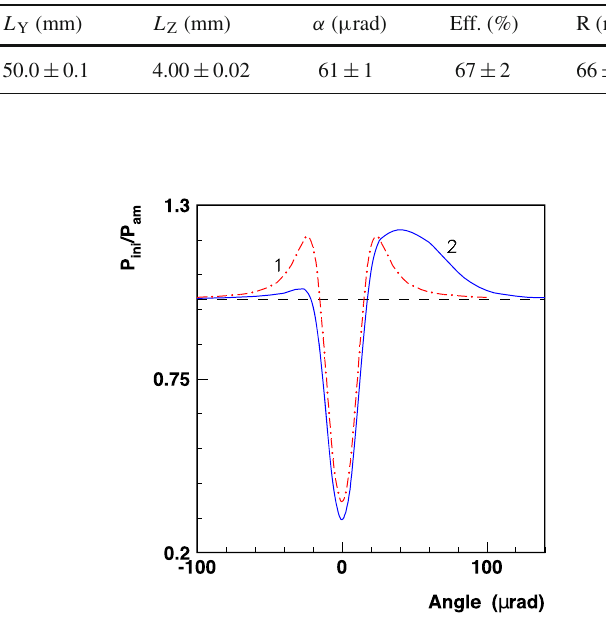
Fig. 3 In red the observed dependence of INI rate for 180 GeV/c posi- tivehadronsontheorientationangleofthecrystal.Thebluecurveshows the analytical simulation results. Both are normalized to the amorphous level (black dashed line)